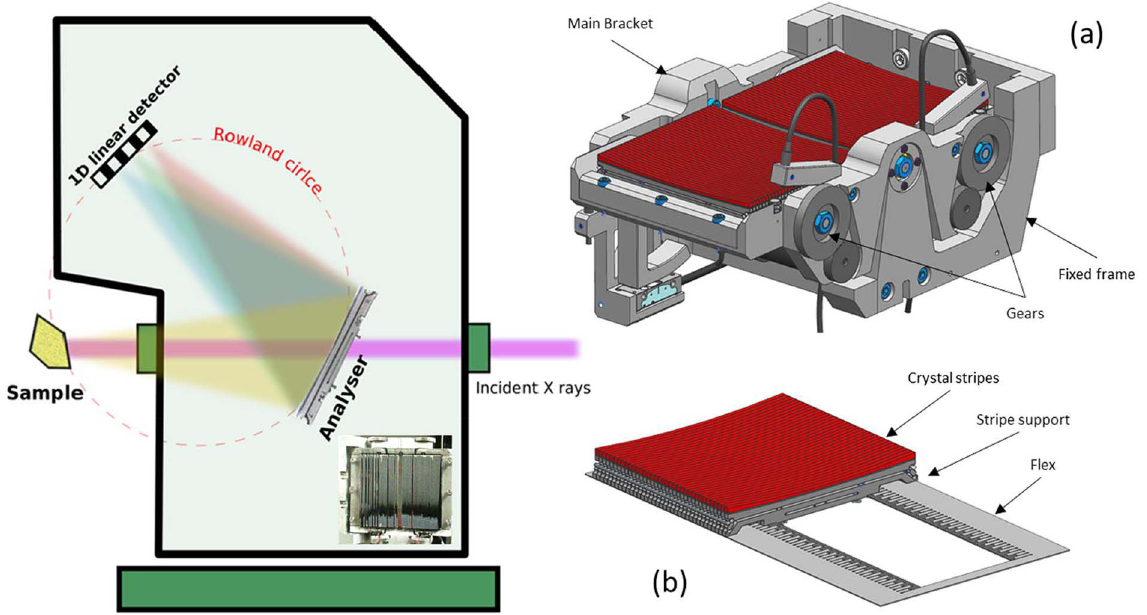
Figure 1 (Left) Schematic representation of the CLEAR spectrometer where the inset shows an image of the available Si(111) analyzer. (Right) Technical drawings of the Johansson-like CLEAR analyzer. ( a ) Full analyzer, where the main bender degrees of freedom are highlighted: the gears allowing the bending and the bracket permitting the scattered light on the detector to be aligned. ( b ) The flex on which the 72 crystal stripes glued on Al supports are mounted. The Al supports permit a fine angular alignment along the two directions perpendicular to the crystal